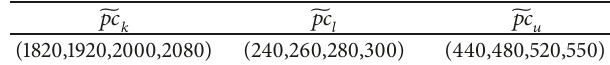
Table 8: Unit processing cost